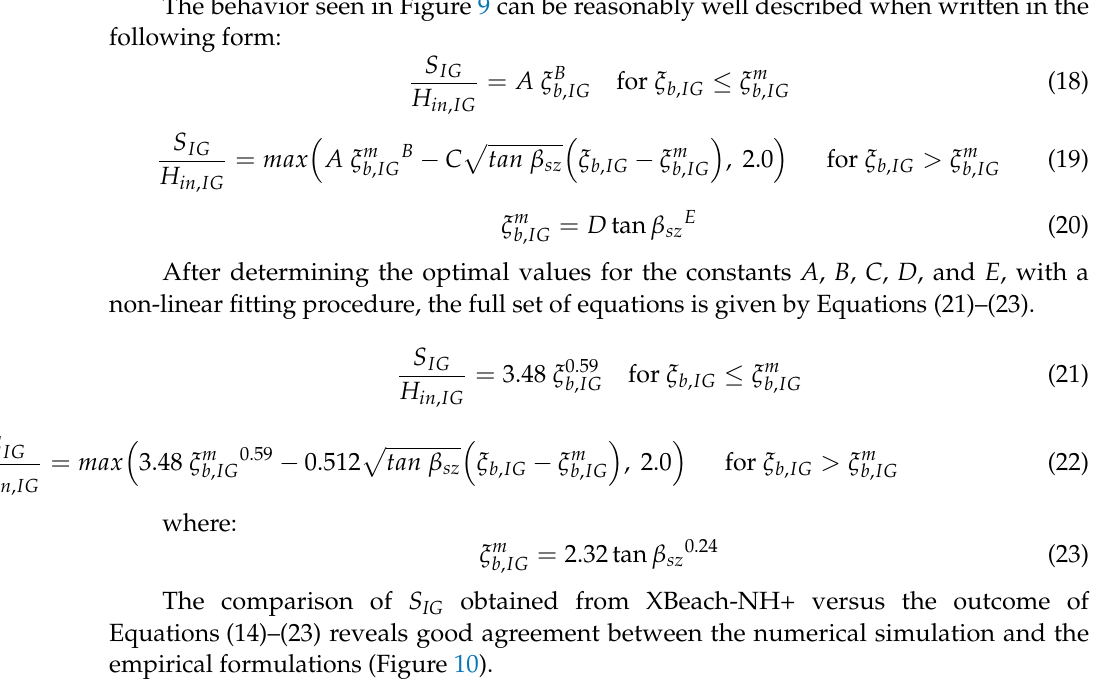
Figure 9. Relative infragravity run-up S IG /H in,IG as a function of ξ b,IG and tan β sz . Solid lines are the empirical fit for tan β sz = 0.005, tan β sz = 0.02, and tan β sz =